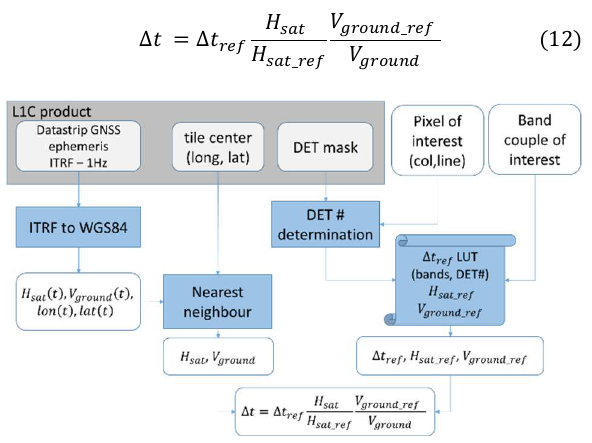
Figure 17 : L1C interband delay estimation processing chain.